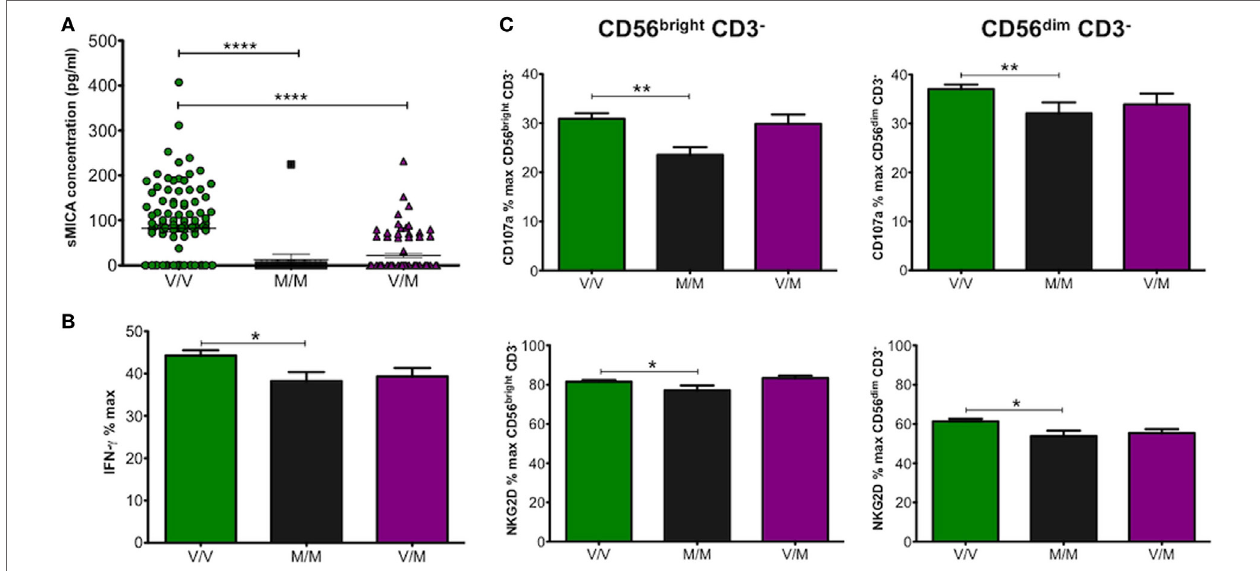
FigUre 5 | (a) Effect of allelic MHC class I-related chain A (MICA) differences encoding MICA-129val (V/V), MICA-129met (M/M), or heterozygotes (V/M) on concentration of sMICA (pg/ml) found in cord blood plasma (CBP) samples. Values for sMICA concentration were obtained by ELISA for each CBP sample. (B) Production of IFN- γ (%max) by peripheral blood mononuclear cells (PBMCs) incubated with CBP from umbilical cord blood encoding MICA allelic variants MICA-129val or -met. (c) CD107a and NK group 2, member D (NKG2D) levels detected on CD56 bright and CD56 dim natural killer cells. Each experiment was repeated with four different PBMC donors and data points represent donor means (B,c) . Statistical analysis was performed using Kruskal–Wallis test with Dunn’s post hoc test ± SEM (a) or Mann–Whitney test ± SEM (B,c) (* P ≤ 0.05, ** P < 0.01, and **** P <